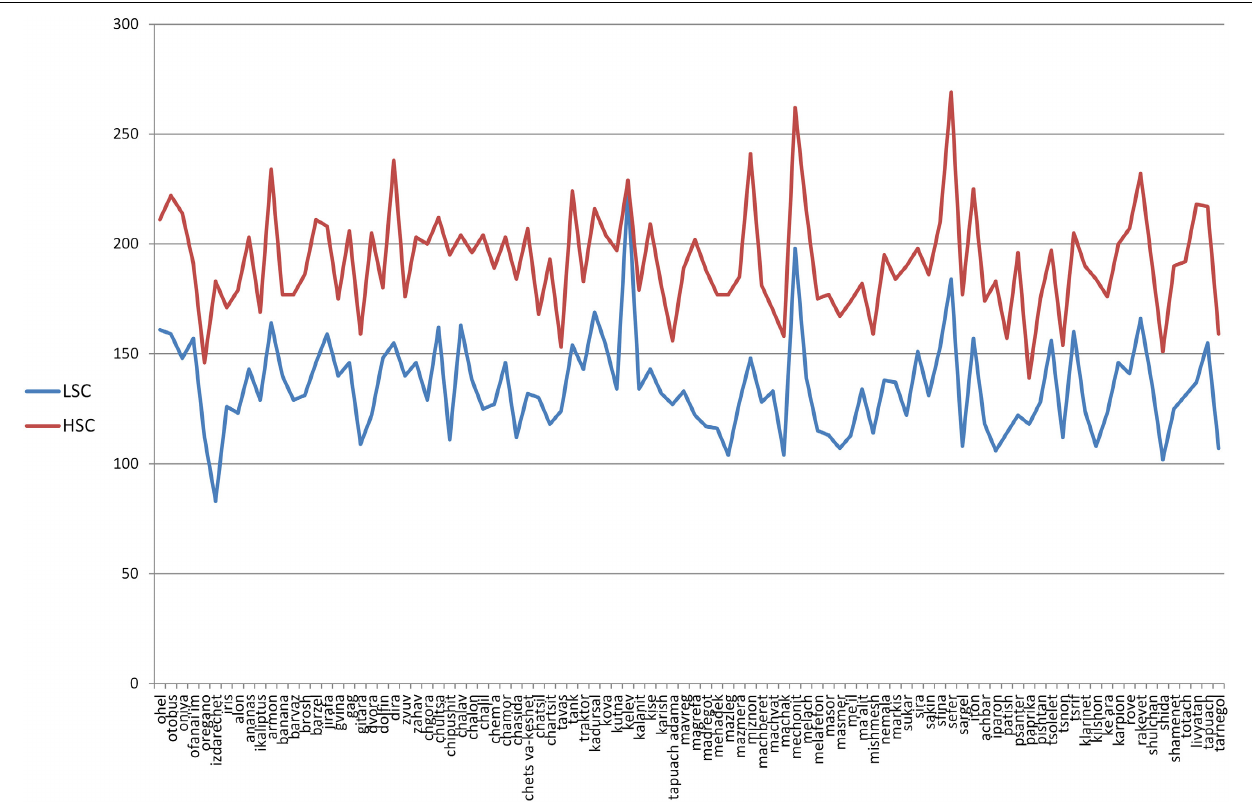
FIGURE 2 | Average unique association responses generated for target words for the LSC and HSC groups. X-axis, 96 target words used in the research; Y-axis, amount of mean association responses for a target word. LSC, low semantic creativity group; HSC, high semantic creativity group.